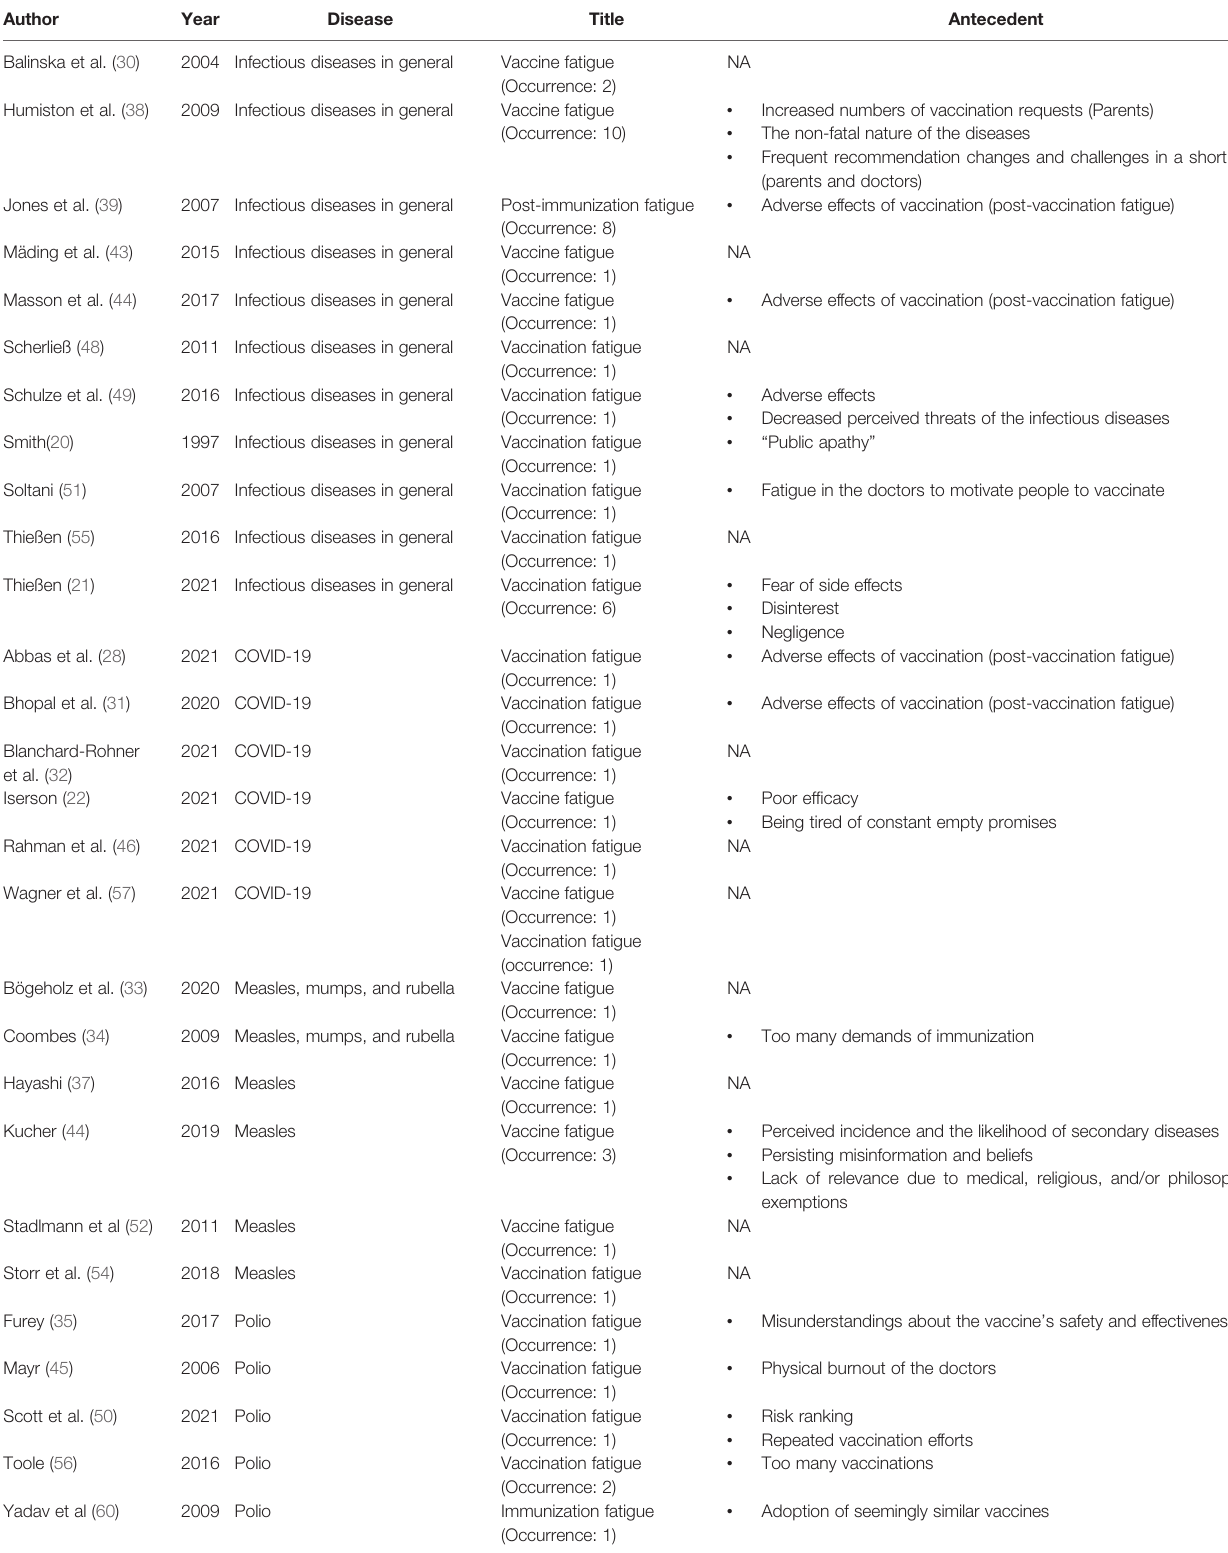
TABLE 1 | A summary of key insights from the reviewed